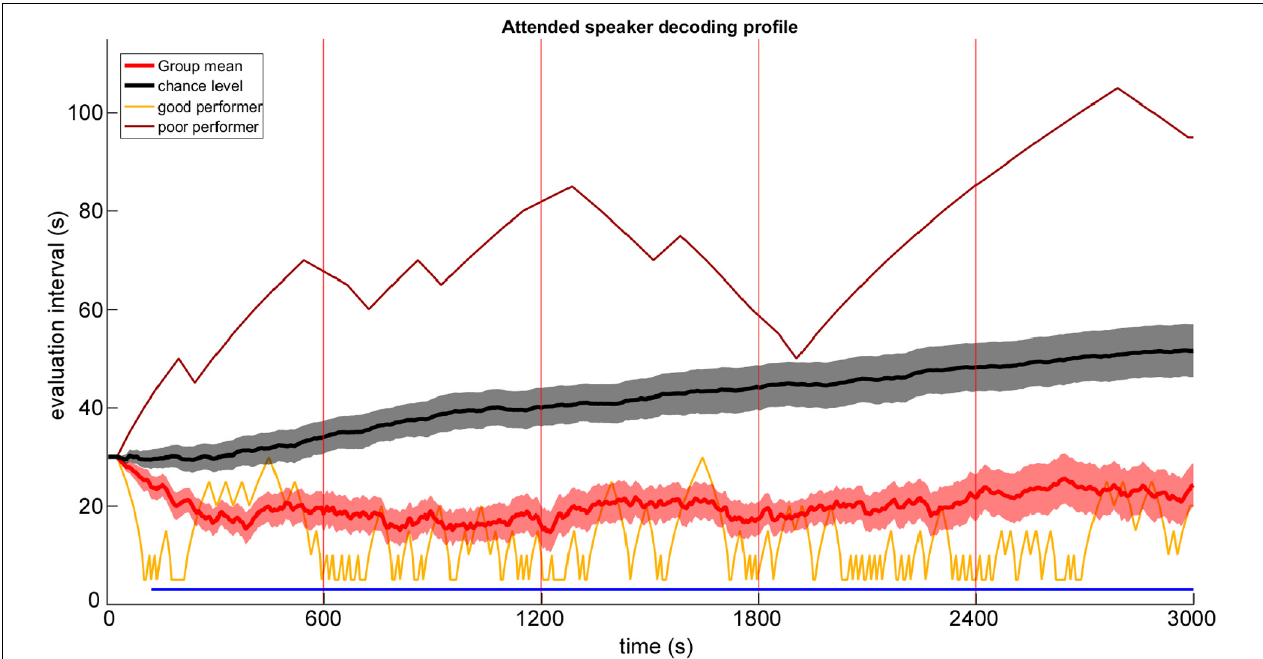
FIGURE 3 | Group mean attended speaker decoding profile (red line) with ± 1 SEM (red shaded area) plotted as a function of time. Single subject results are given for the worst and best performing participant. Black line and gray shaded area indicates the chance level with ± 1 SEM determined by the permutation approach. The horizontal blue line marks a significant difference between attended speaker decoding profiles and chance level (running Wilcoxon signed rank test, p < 0.05, False Discovery Rate corrected). Red vertical lines mark pause intervals between testing